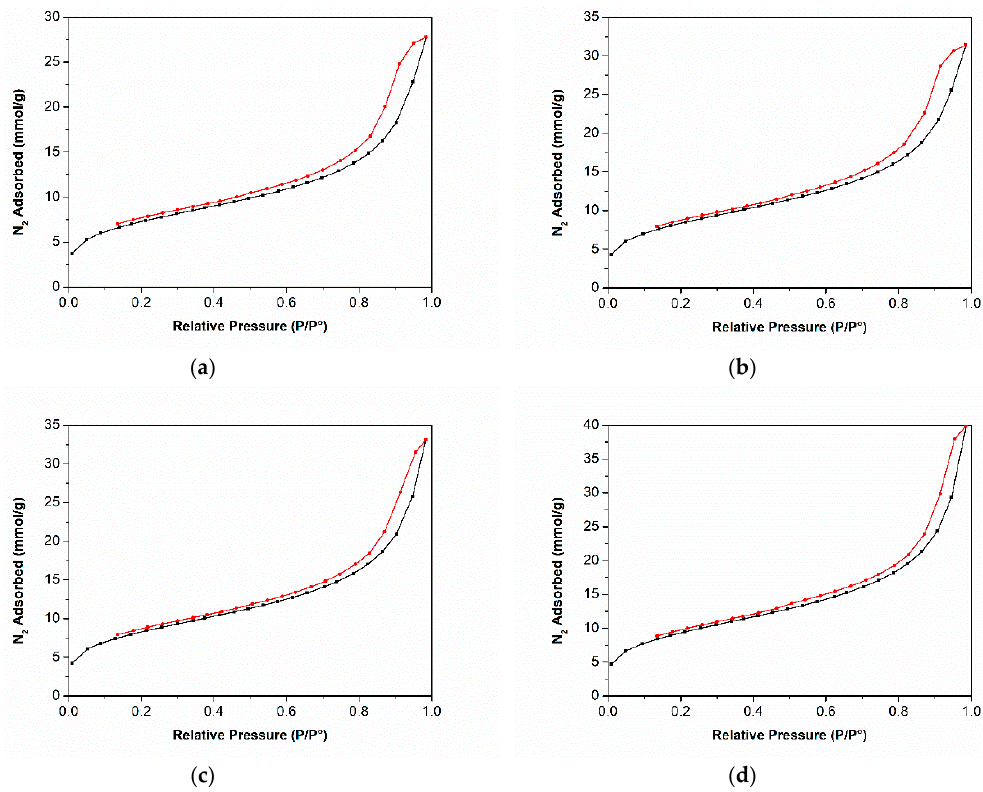
Figure 3. N 2 adsorption-desorption isotherm at –196°C for the PdAS(x)-MA catalysts. ( a ) Pd-AS(1)-MA, ( b ) Pd-AS(2)-MA, ( c ) Pd-AS(5)-MA, and ( d ) Pd-AS(10)-MA.